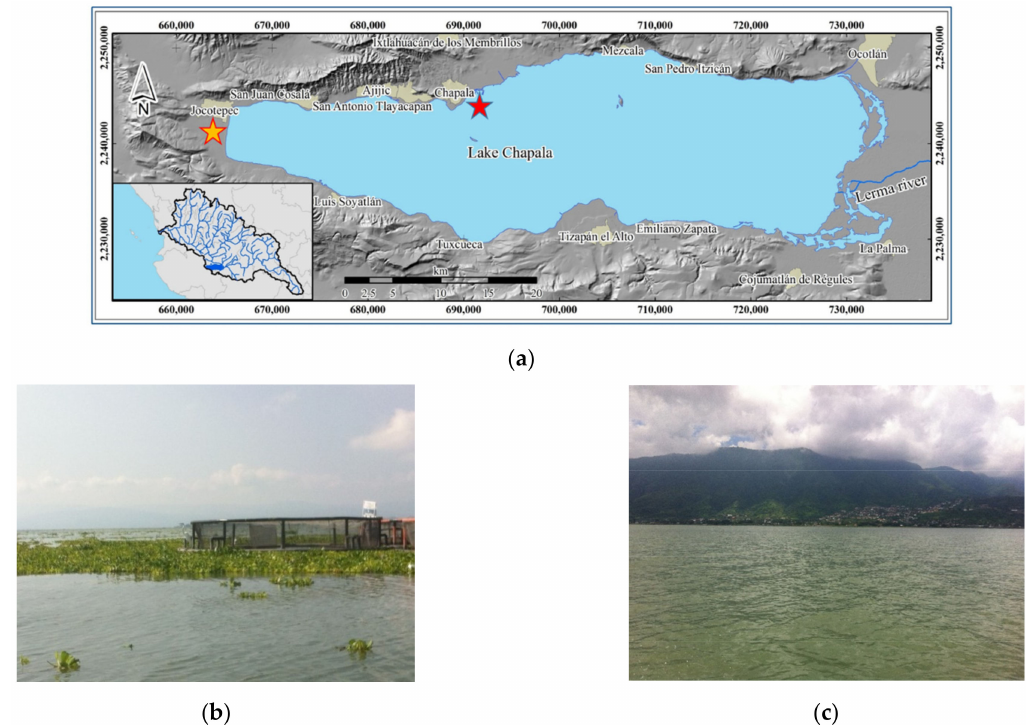
Figure 1. Location of the experimental cage in Lake Chapala. ( a ) Map of Lake Chapala showing with the red star the experimental cage and the yellow star the control group. ( b ) Experimental cage. ( c ) General view of Lake Chapala